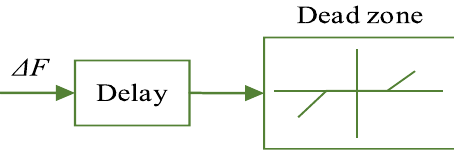
Fig. 4 Droop controller of the proposed type 3 wind